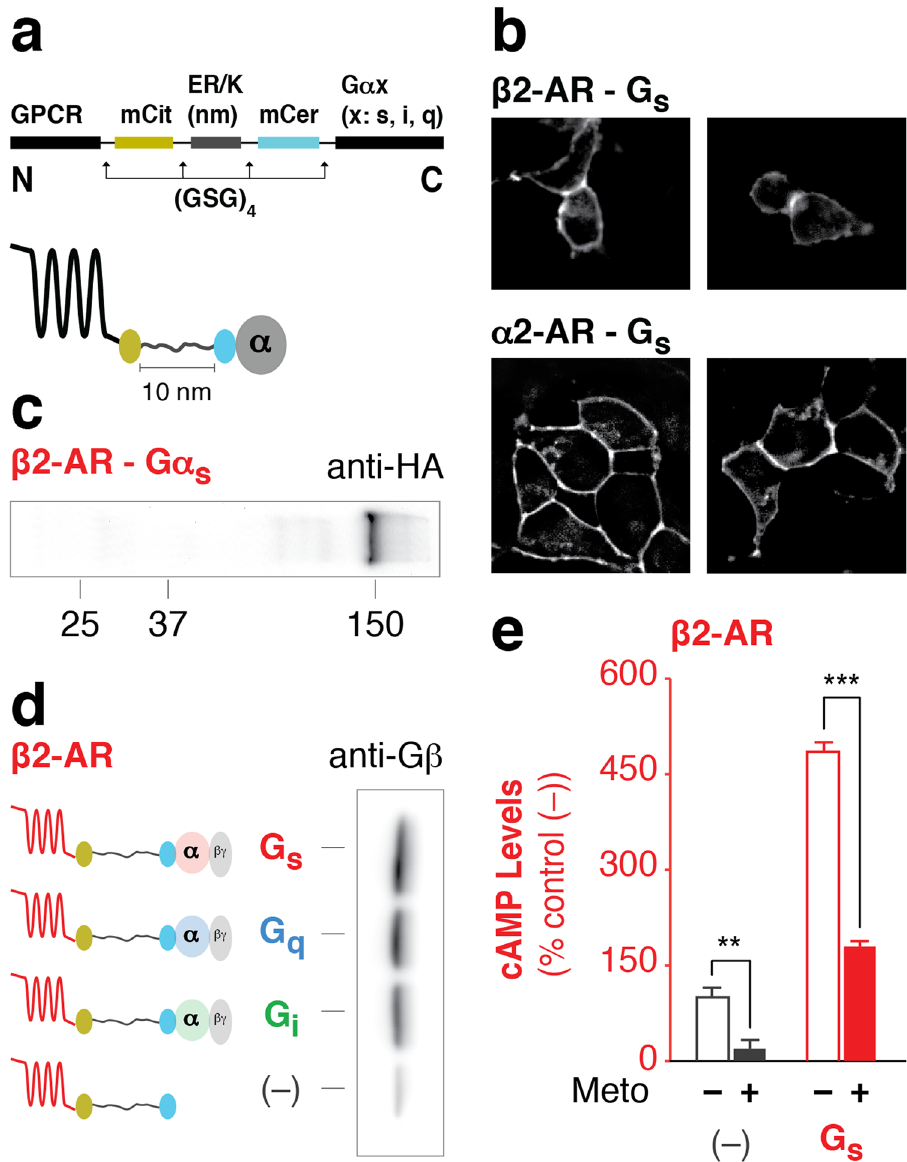
Figure 1. GPCR-G protein fusion sensors are intact and functional. ( a ) Schematic of the GPCR-G protein sensor design. Protein domains are separated by (GSG) 4 linkers to ensure rotational freedom. Control (–) sensors do not contain a G α subunit. ( b ) Sensors localize to the plasma membrane in live HEK293T cells as shown in representative images. ( c ) Western blot of membranes expressing HA- β 2-AR-G α s probed with anti-HA antibody. A distinct 150 kDa band indicates intact sensor expression. ( d ) Membranes expressing HA- β 2-AR-G α x sensors were subjected to HA-affinity purification and probed with anti-G β antibody. Equivalent amount of sensor is loaded per lane as assessed by mCitrine fluorescence. G β associates with the G α s, G α i, or G α q subunit. ( e ) cAMP production in the presence or absence of inverse agonist (100 μ M metoprolol) for β 2-AR tethered with or without Gs. Data are derived from at least three independent experiments, with at least three replicates per condition. Data are represented as % no-G protein control (–) (mean ± S.E.M Student’s t-test was performed to evaluate significance ** p ≤ 0 . 01 and *** p ≤ 0 . 001